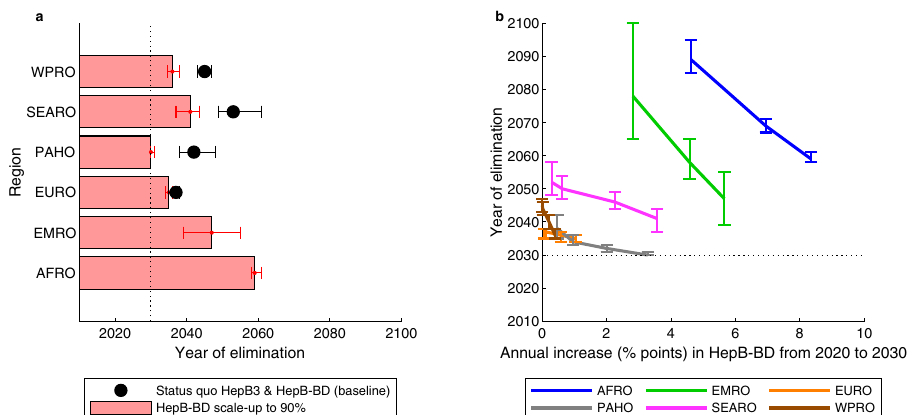
Fig. 4 The impact of timely HepB-BD scale-up on achieving WHO elimination targets. a Median year by which the elimination target (0.1% HBsAg prevalence in fi ve-year-olds) is reached in the WHO regions, with 95% credibility intervals, in the status quo HepB3 & HepB-BD scenario (black dots) and the scenario in which timely HepB-BD coverage is scaled up to ≥ 90% by 2030 (HepB-BD scale-up scenario; red bars). b Median year of elimination, with 95% credibility intervals, for different levels of annual scale-up of timely HepB-BD coverage (the HepB-BD scale-up scenarios) in the populations within each of the WHO regions. The dotted lines for the year 2030 are for reference purposes only. For each WHO region, number of HBsAg prevalent cases in fi ve-year-olds and total number of fi ve-year-olds were summed across countries. Number of HBsAg prevalent cases in fi ve-year-olds was divided by total number of fi ve-year-olds to give HBsAg prevalence in fi ve-year-olds. The year of elimination was identi fi ed as the year in which HBsAg prevalence in fi ve- year-olds falls below 0.1%. This was repeated n = 200 times using independent draws from the posterior distribution of each country. The six WHO regions AFRO, EMRO, EURO, PAHO, SEARO and WPRO are shown in Supplementary Fig. 1. HBsAg: hepatitis B surface antigen; HepB3: infant HBV